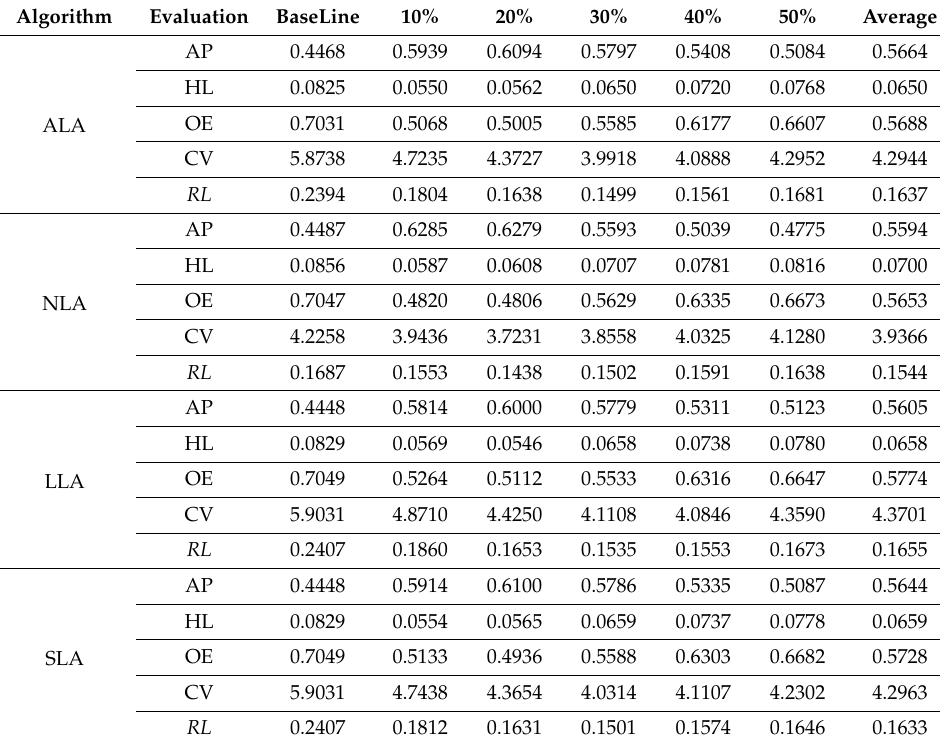
Table 6. Experimental results on Entertainment data